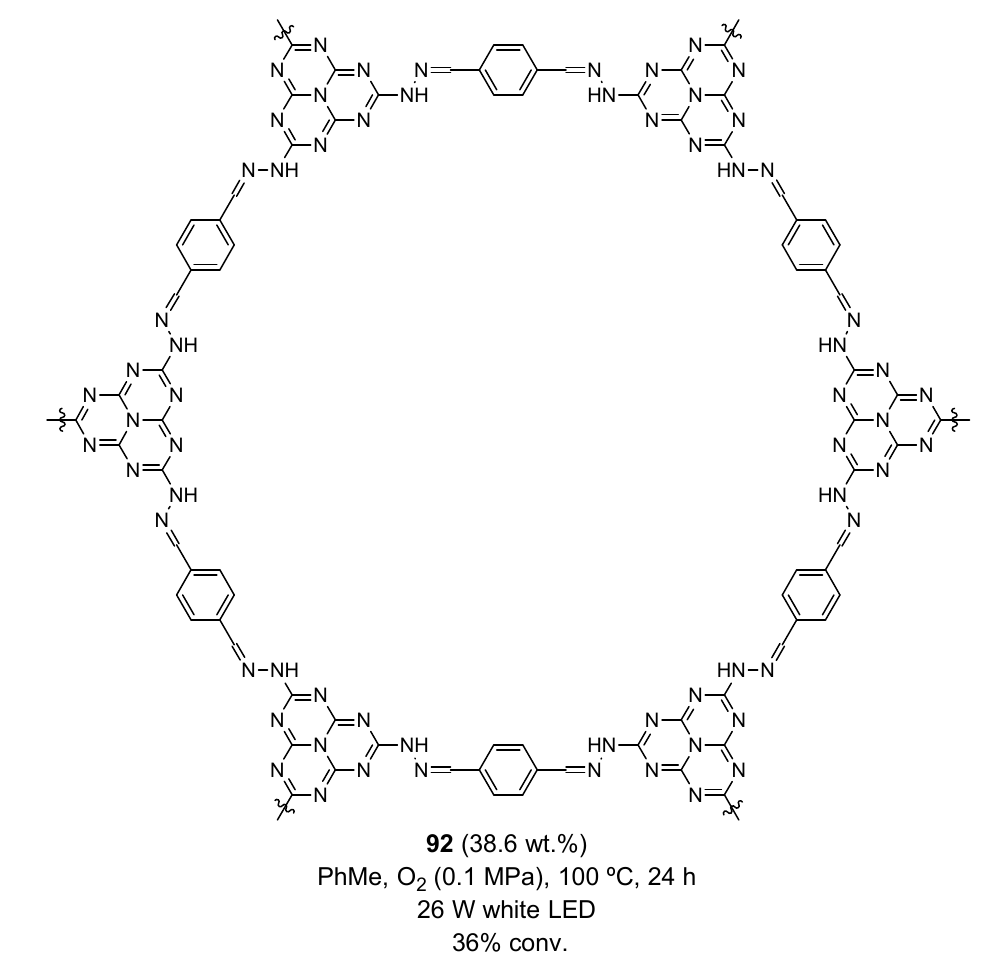
Figure 26. Result obtained in the aerobic photo-oxidation of benzyl alcohol to benzaldehyde catalyzed by 92 .